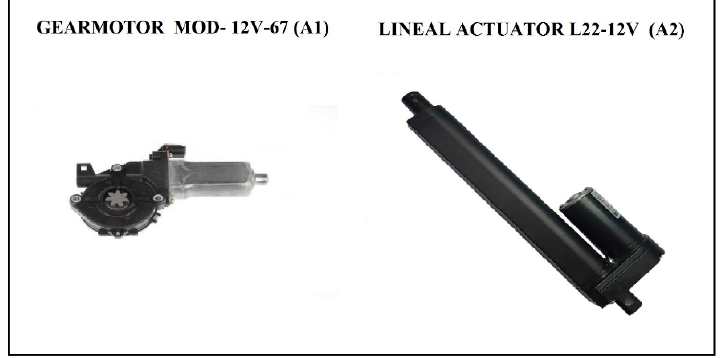
Figure 6. Illustration of selected actuators.